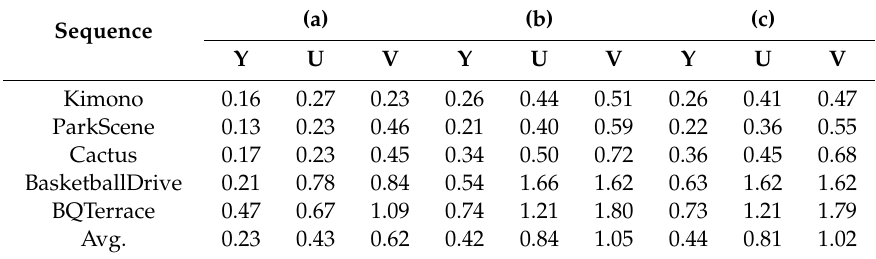
Table 6. Coding performance of the additional coding orders of (a) above-right to bottom-left, (b) above-right to bottom-left and bottom-right to above-right, and (c) above-right to bottom-left, bottom-right to above-right, and bottom-right to above-left.